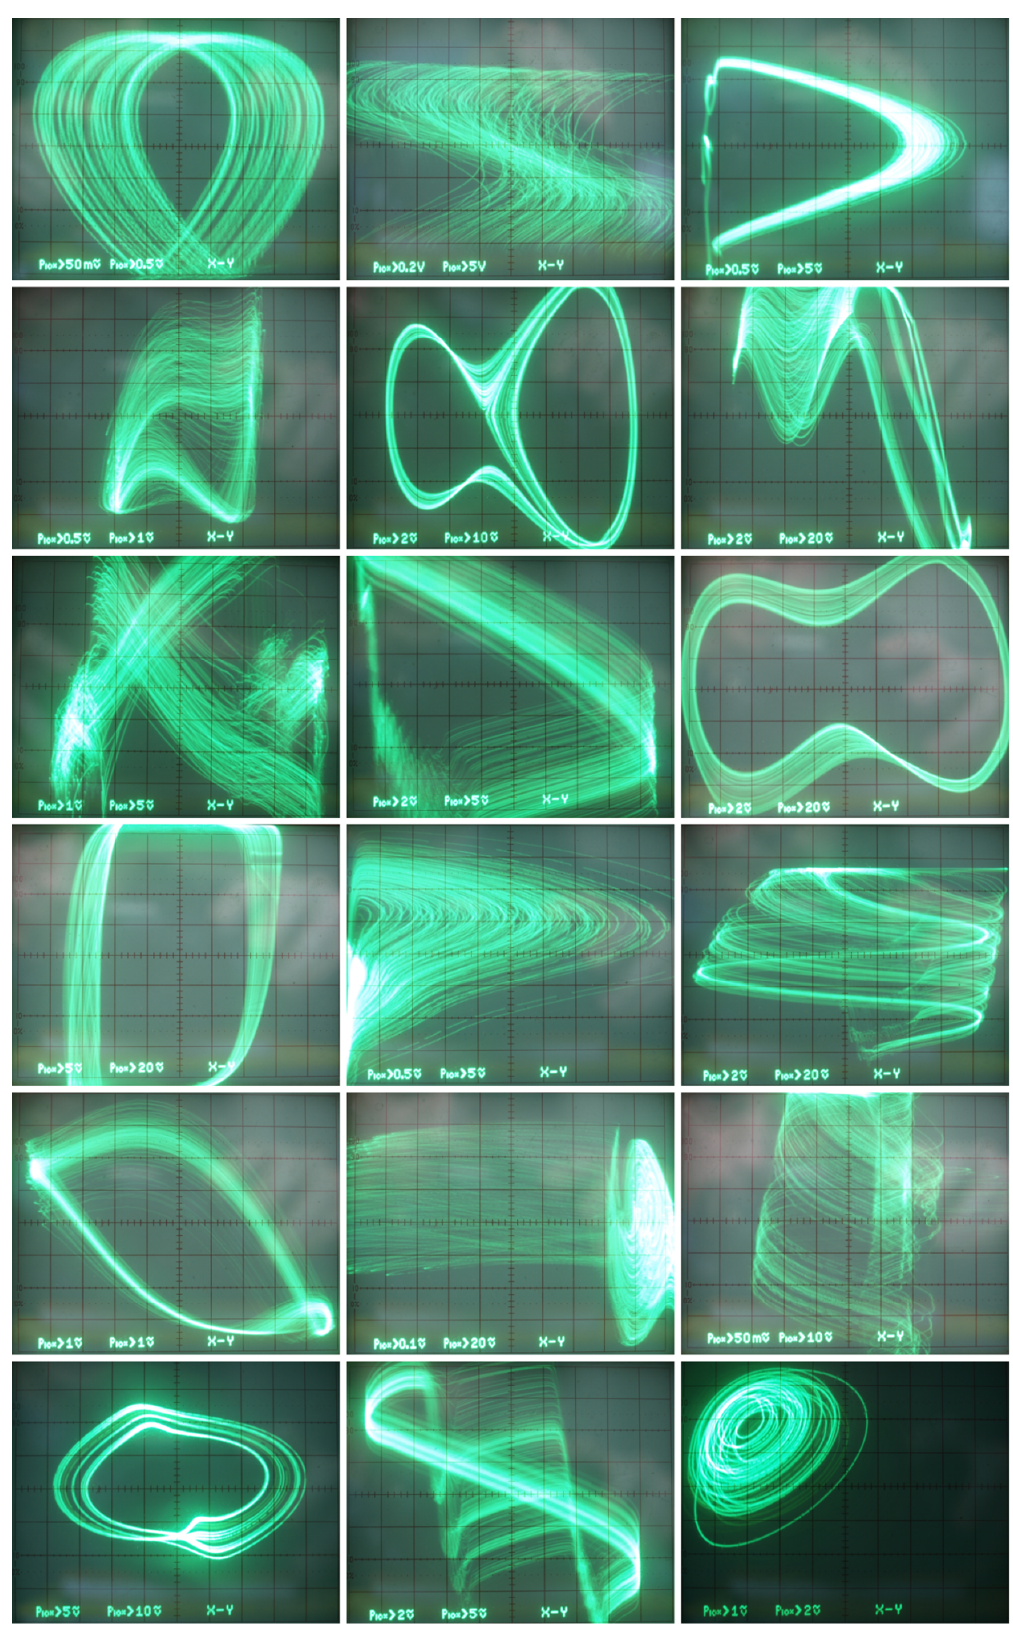
Figure 17. Experimental confirmation of strange attractors in oscillator defined by Equation (13).